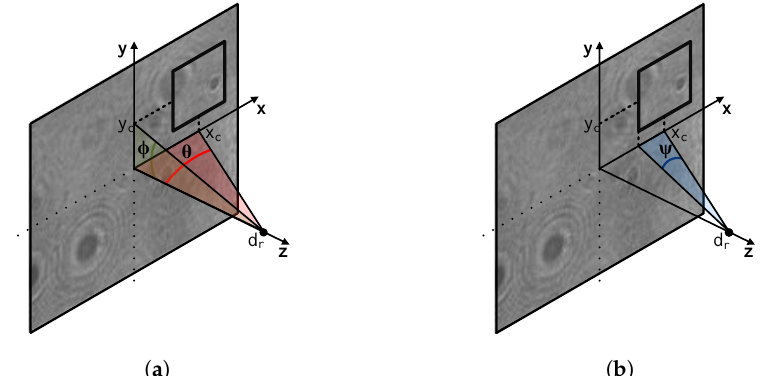
Figure 2. Synthetic aperture position expressed with the angles θ and φ ( a ) and size expressed with the angle ψ ( b ).